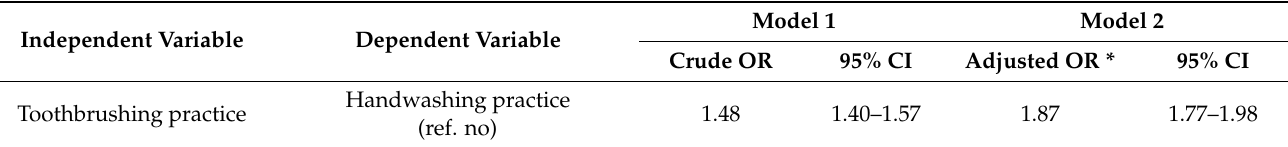
Table 3. Relationship between toothbrushing and handwashing.